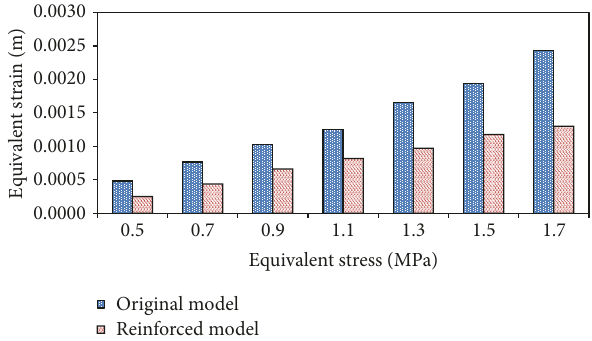
Figure 15: Equivalent strains of two kinds of masonry